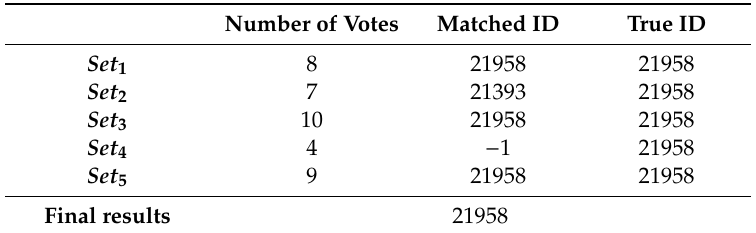
Table 3. Example of results after the second procedure for one reference